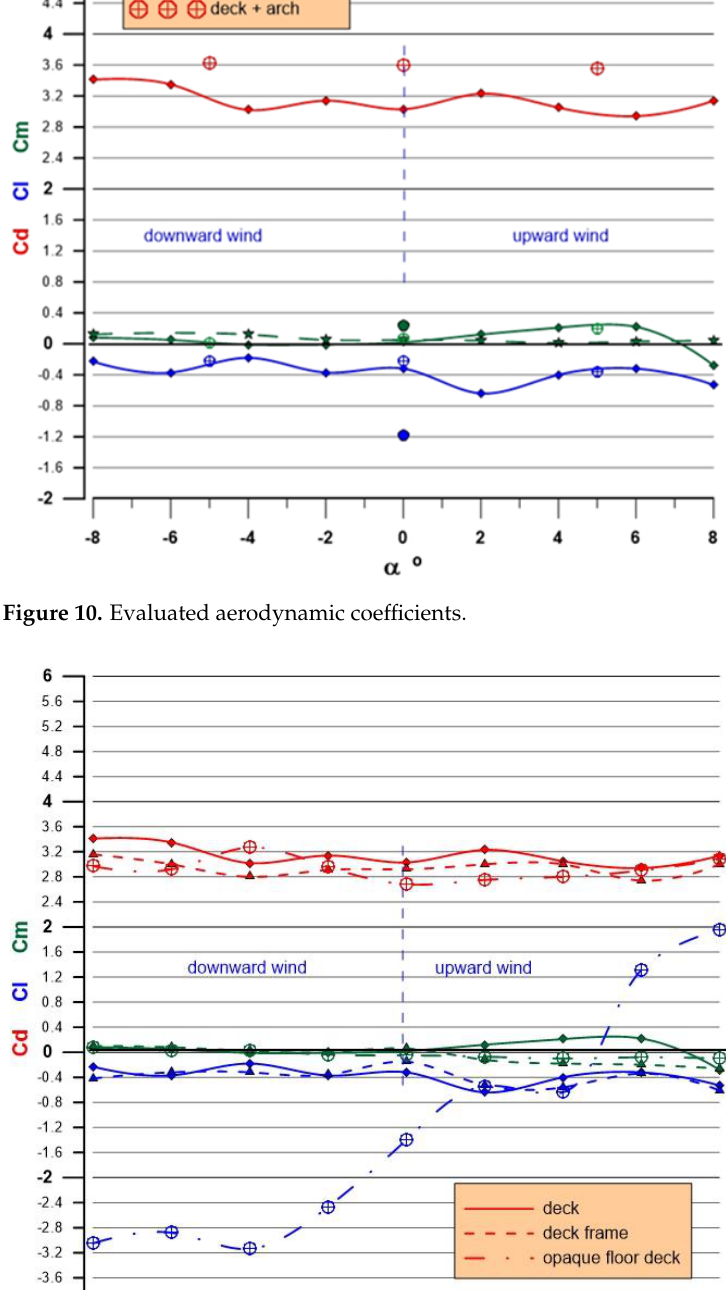
Figure 12. Arch drag coefficient for varying incidences. The opportunity to look into the floor mesh influence and how an opaque floor would change those aerodynamic coefficients was taken, the only significant difference relating, as expected, to the lift evolution getting closer to a flat plate ’s behaviour or that of other opaque decks [9]. Due to the fact that the model was hung by a flexible system, the question of a possible variation in the angle of attack, when evaluating the static aer-